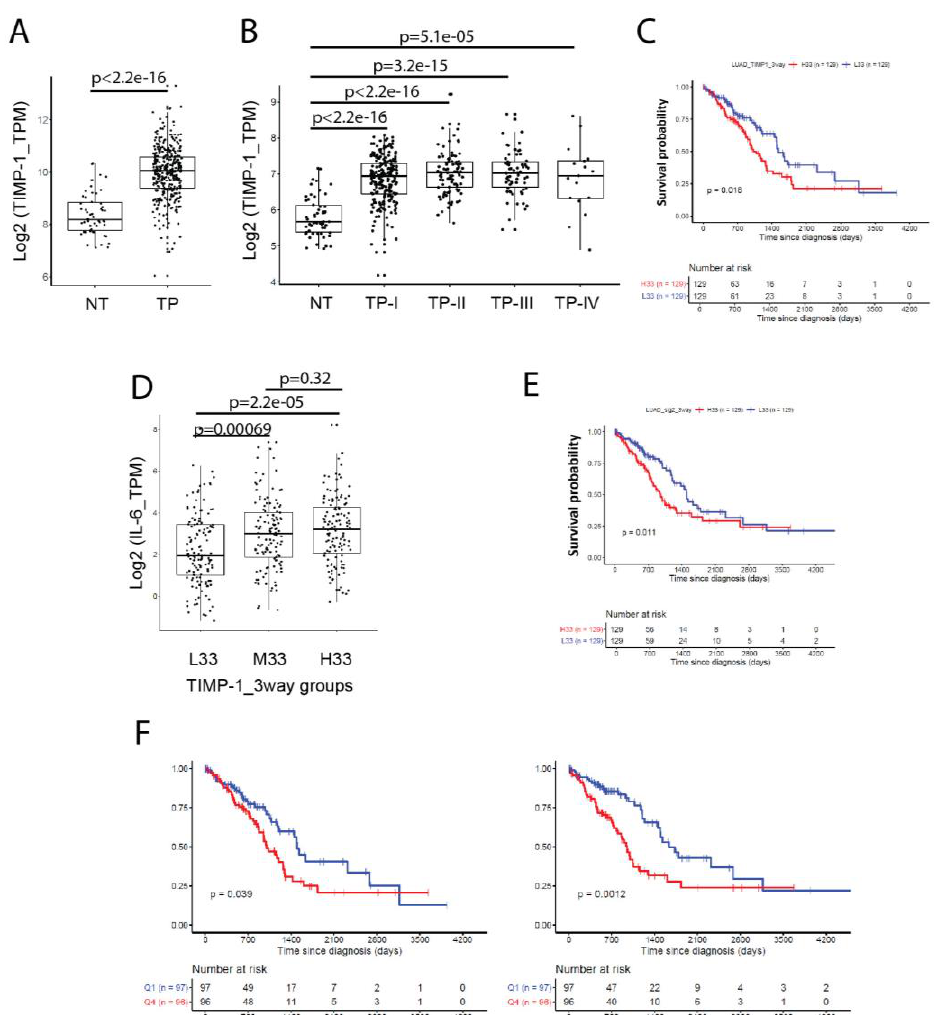
Figure 6. Meta-data analysis of TIMP-1 and IL-6 coexpression and the relationship with survival in clinical lung adenocarcinoma (LUAD) databases. ( A ) Mining the clinical lung adenocarcinoma of the Cancer Genome Atlas network (TCGA) data set (http: // www.oncolnc.org) and comparison of TIMP-1 expression between tissues of primary tumor (TP) and adjacent normal tissues (NT). ( B ) Comparison of TIMP-1 expression in TP tissues and NT at four different stages. ( C ) Three-way grouping of LUAD patients based on TIMP-1 gene expression levels, and Kaplan–Meier survival analysis of patient sub-populations with high (H33) and low (L33) levels of TIMP-1 expression. ( D ) Comparison of IL-6 expression among patient sub-populations with different TIMP-1 expression levels. ( E ) Three-way grouping of LUAD patients based on TIMP-1 and IL-6 co-expression levels (two-gene signature) and Kaplan-Meier survival analysis of patient sub-populations with different levels (H33 and L33) of TIMP-1 and IL-6 co-expression. ( F ) Four-way grouping of LUAD patients based on TIMP-1 gene expression levels (single gene, left panel) or TIMP-1 and IL-6 co-expression levels (two-gene signature) (right panel), respectively, and Kaplan–Meier survival analysis of patient sub-populations with high (Q4) and low (Q1) levels of TIMP-1 expression or TIMP-1 and IL-6 co-expression. Statistical significances (log-rank test) were indicated ( p < 0.05 is considered to be significant).